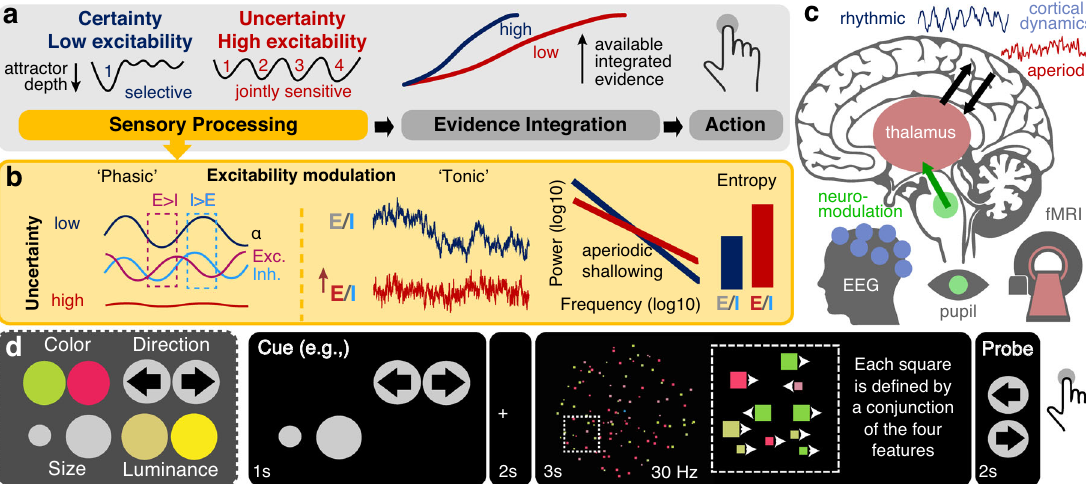
Fig. 1 Hypotheses and task design. a We probed whether uncertainty modulates cortical excitability during stimulus processing to guide subsequent evidence accumulation. We hypothesized that when cues specify the relevance of a single stimulus feature in advance, a low excitability regime may optimize subsequent choices via the targeted selection of relevant — and inhibition of irrelevant — information. In contrast, higher excitability may afford the concurrent sampling of multiple relevant features when the relevance of speci fi c features is uncertain, but at the cost of a relative reduction of